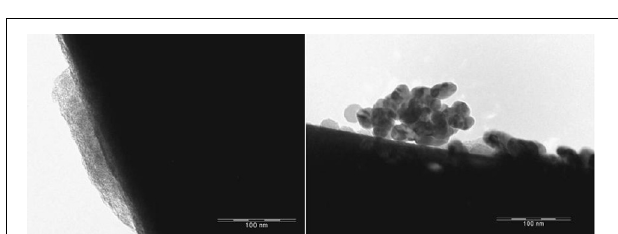
FIGURE 3 | EFTEM pictures of the catalyst containing palladium in (ADBA)(tBuO)on ACC as fresh (left) and after being exposed to citral hydrogenation procedure.